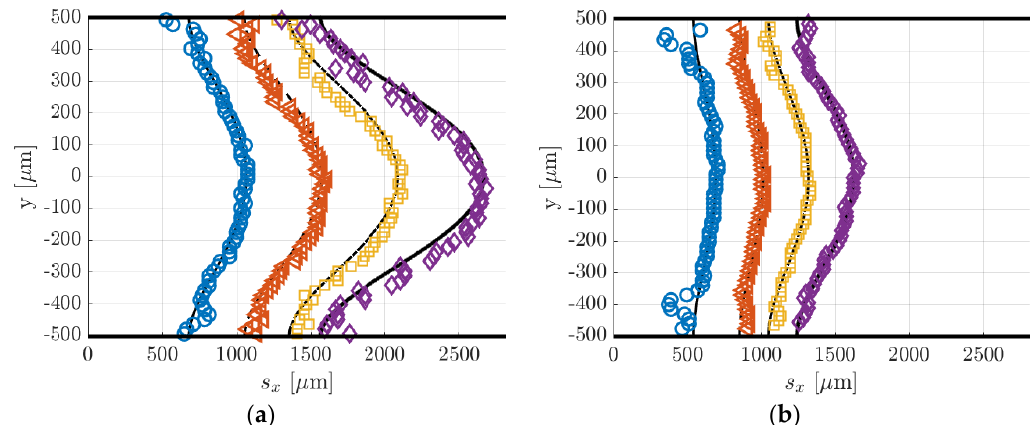
Figure 19. ( a ) Displacement data computed by applying the Gaussian fitting per line to the MTV images at ( a ) 𝑝 𝑚 = 1580 Pa (Figure 17) and ( b ) 𝑝 𝑚 = 920 Pa (Figure 18): Δ𝑡 = 20 µs ( O ), 30 µs ( ), 40 µs ( ☐ ), and 50 µs ( ◇ ). The black lines represent the numerical solutions for the displacement profile provided by the reconstruction method. The two figures are on the same spatial scale.